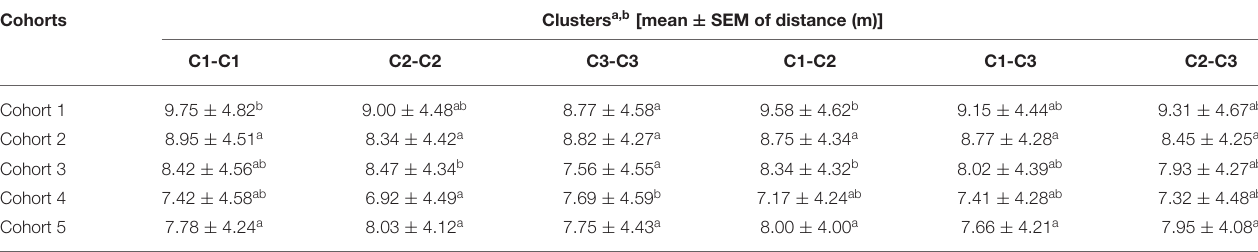
TABLE 2 | Mean ( ± standard error of the mean) of the distance between animals with different personality traits in different cohorts using up to 30m distance data. Cohorts Clusters a,b [mean ± SEM of distance (m)] C1-C1 C2-C2 C3-C3 C1-C2 C1-C3